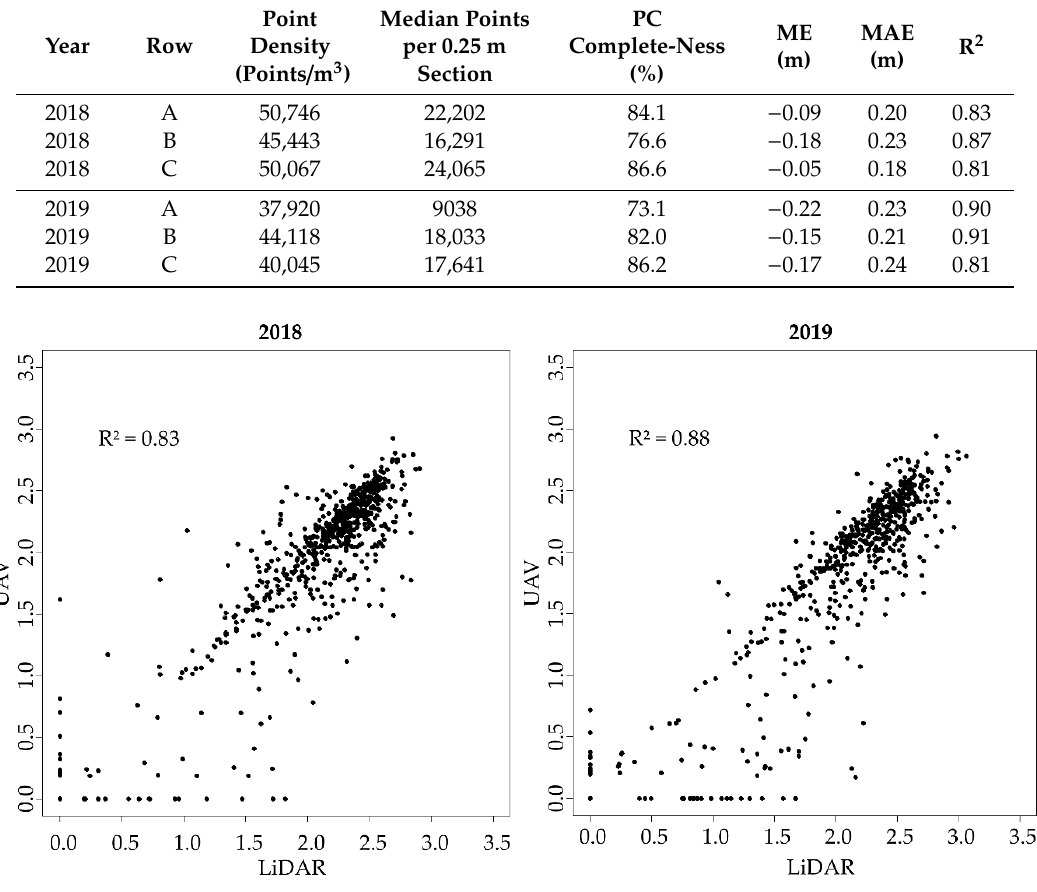
Figure 4. Scatter plots of estimated tree wall heights for grid cells for 2018 and 2019.